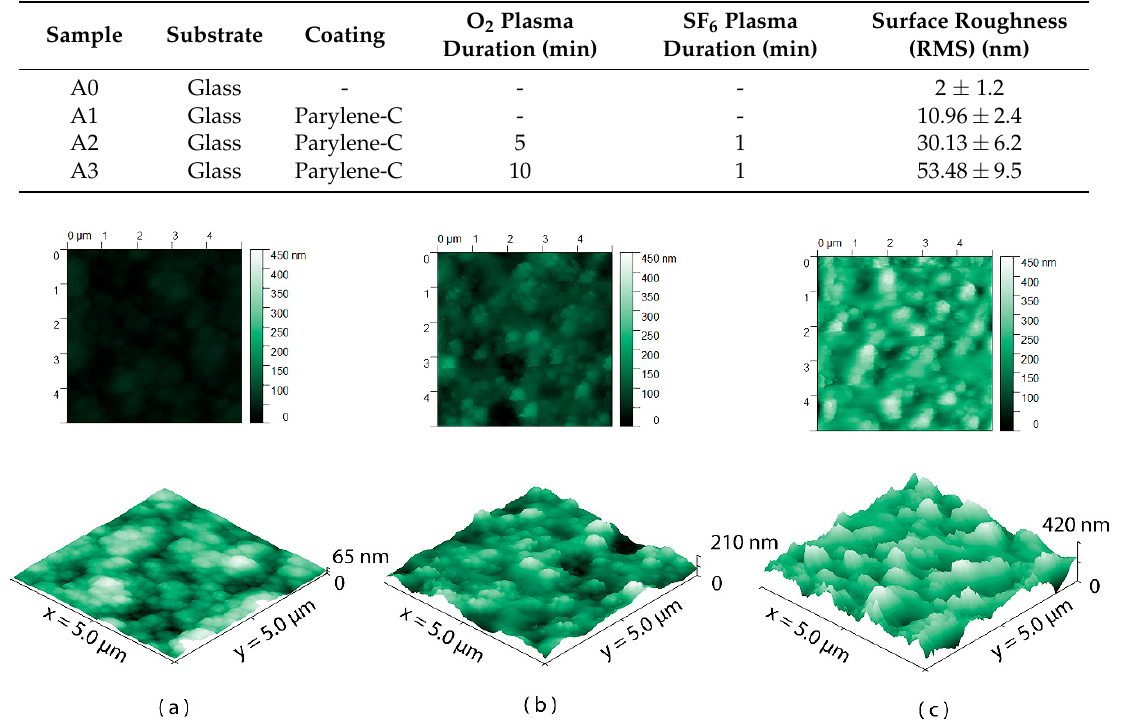
Table 1. Surface roughness measurement.